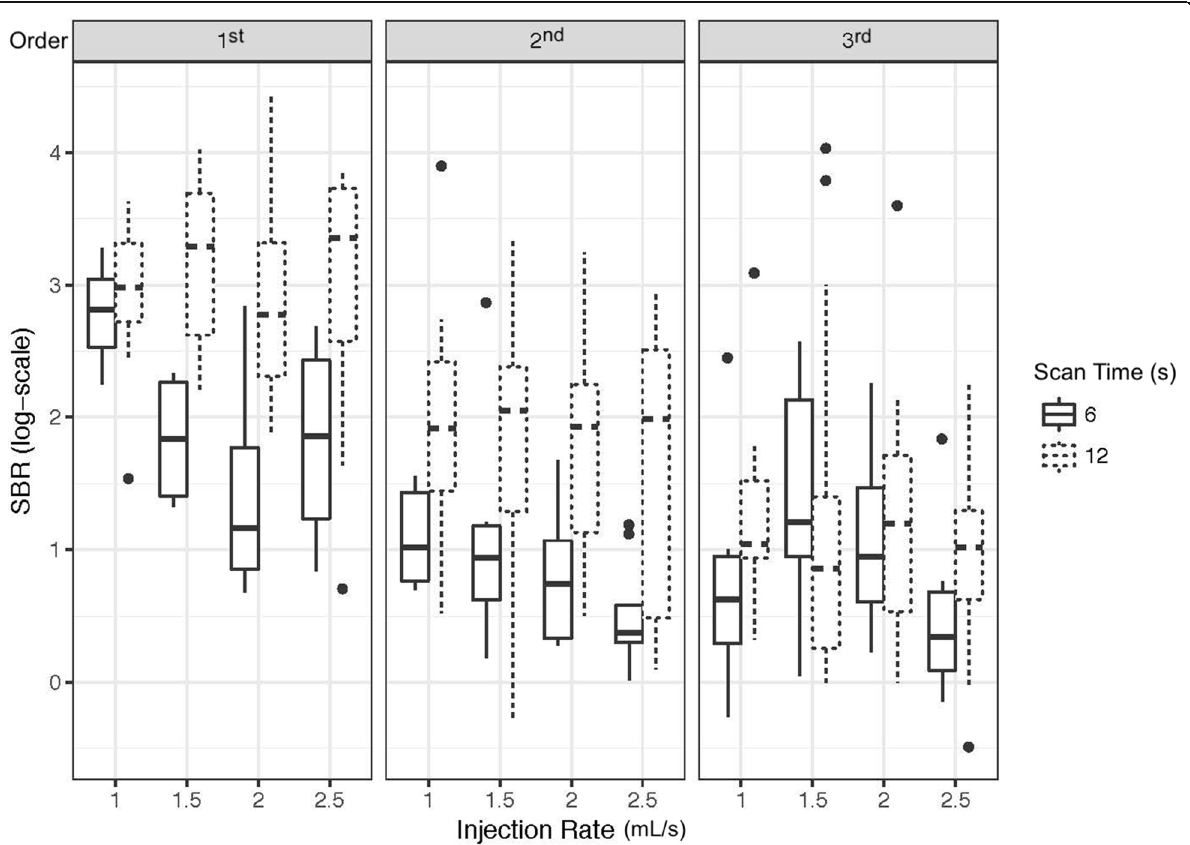
Fig. 3 Box-and-whisker plot of observed sideband ratio (SBR) on the natural log scale for 6-s and 12-s scan times with different injection rates in the 1st, 2nd, and 3rd order hepatic arterial branches. Horizontal lines in the box represent median values. Differences in observed SBR between scan times can be seen to decrease in the more distal (3rd order) branches